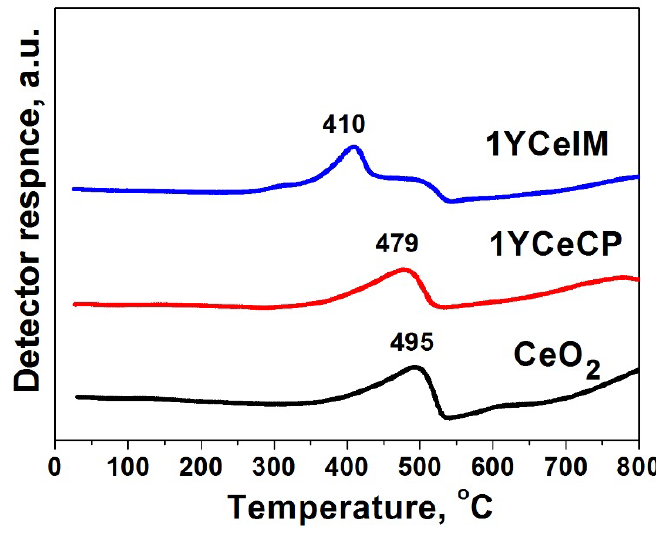
Figure 3. Temperature programmed reduction (TPR) profiles of the initial supports.